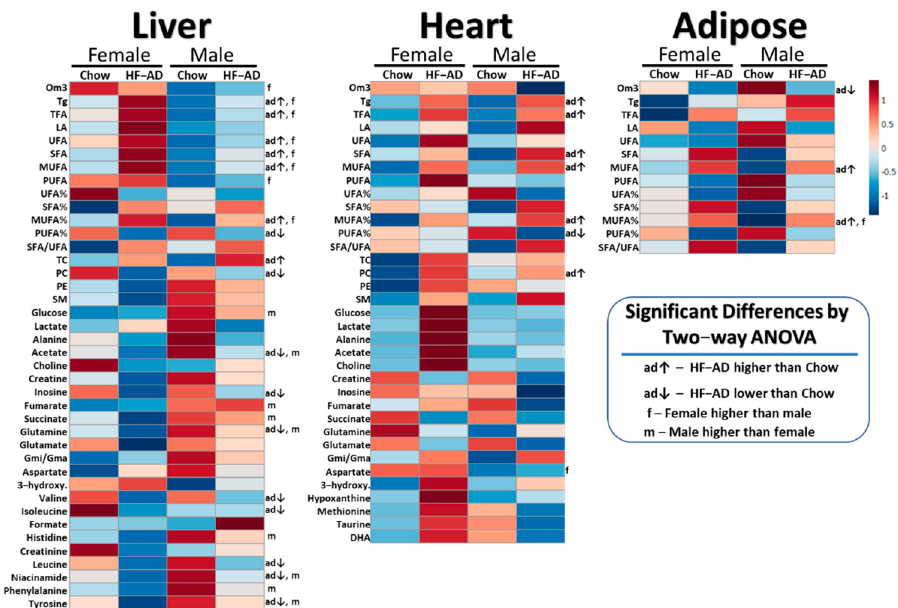
Figure 2. Heatmaps showing mean values of auto-scaled metabolites for both male and female chow